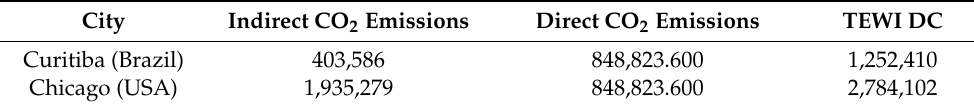
Table 11. TEWI DC (Indirect and direct CO 2 emissions)